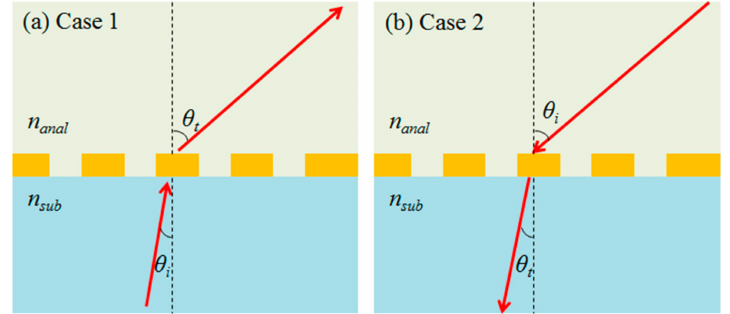
Figure 10. The simplest schemes for refractive index sensing with an HPG MS and tunable refractions when an input beam is incident from ( a ) a substrate side and ( b ) a superstrate analyte side. n anal , n sub , θ i , and θ t denote refractive index of analyte layer, refractive index of substrate, incident angle of an input beam, and refraction angle of a transmitted beam. The yellow patterns represent an arbitrary HPG